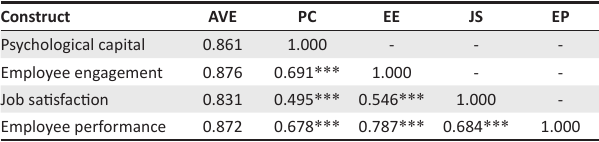
TABLE 3: Discriminant validity index